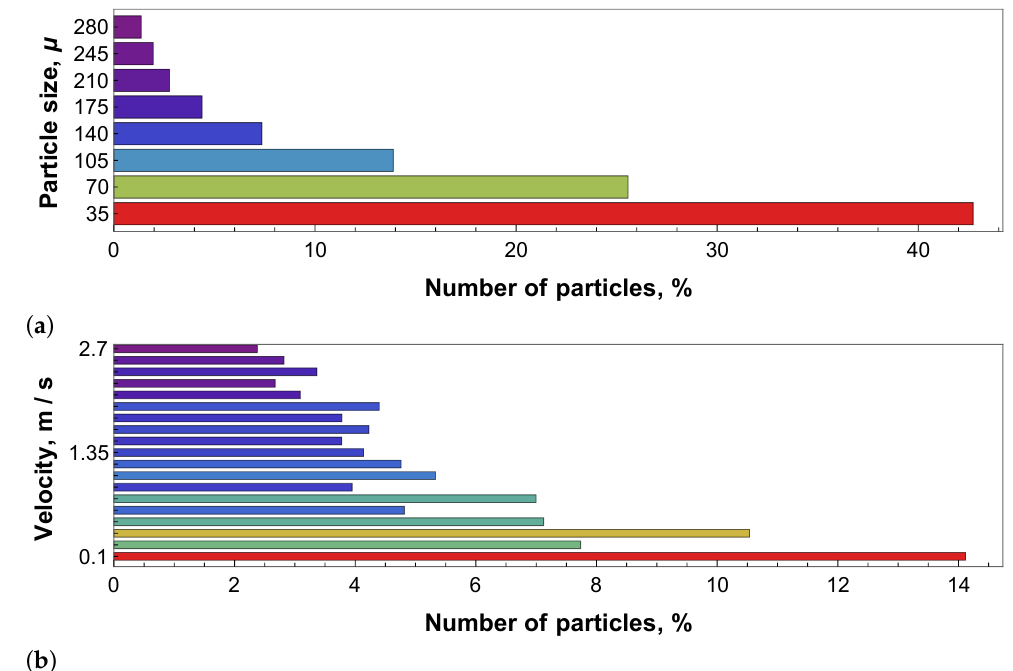
Figure 4. The size ( a ) and velocity ( b ) distribution of the finely atomized particles of the fuel